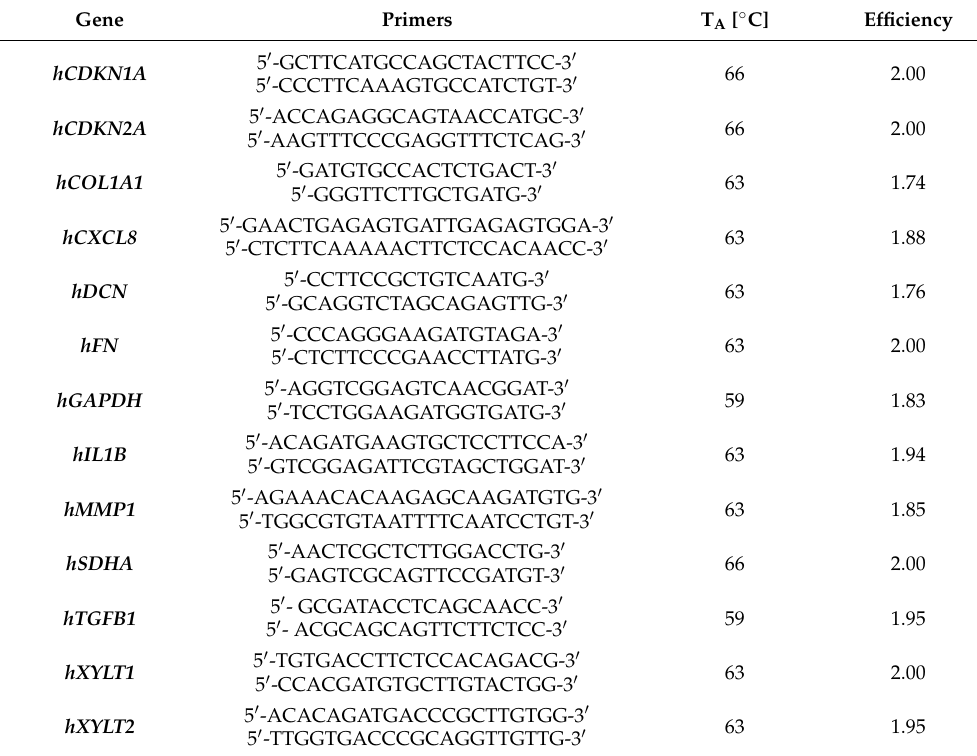
Table 1. Primer pairs used for the qRT-PCR and the respective gene names, annealing temperatures and qPCR